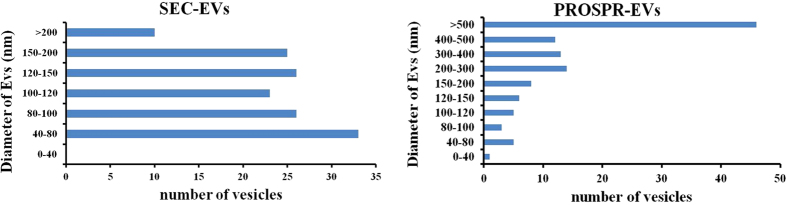
Distribution of the diameter (nm) of vesicles found in SEC and PROSPR preparations.Vesicles detected in Cryo-EM images from either SEC (143 vesicles) or PROSPR (113 vesicles) preparations were counted and the diameter measured using Image J Program. PEG isolated EVs were not detected in Cryo-EM images.